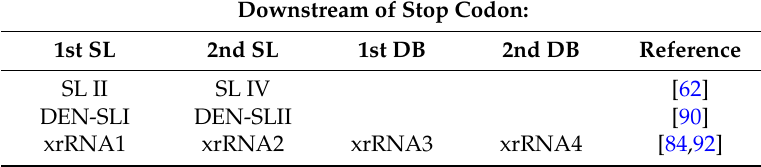
Table 1. Nomenclature used to describe 3 (cid:48) untranslated regions (UTR) stem loop structure of dengue virus (DENV). Downstream of Stop